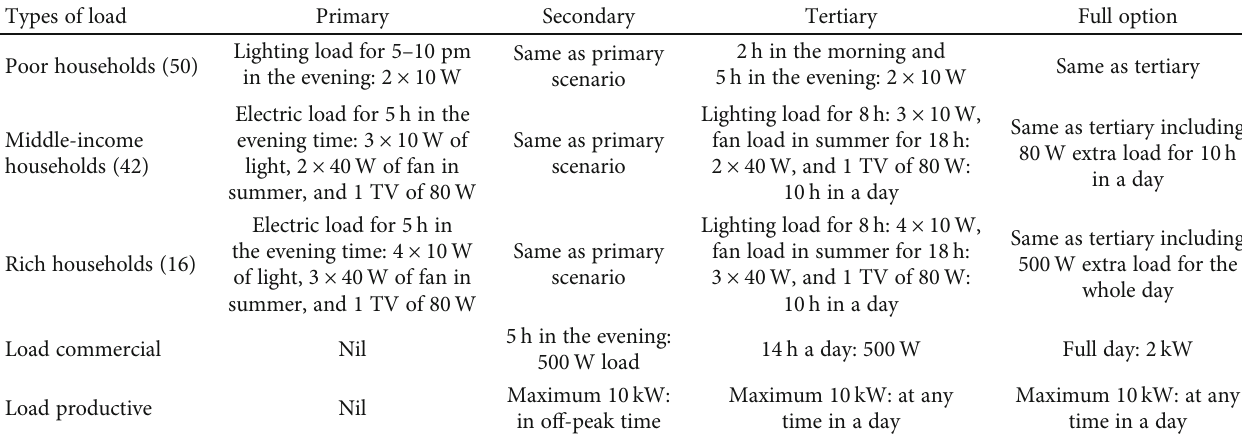
Table 1: Electric load demand estimation.